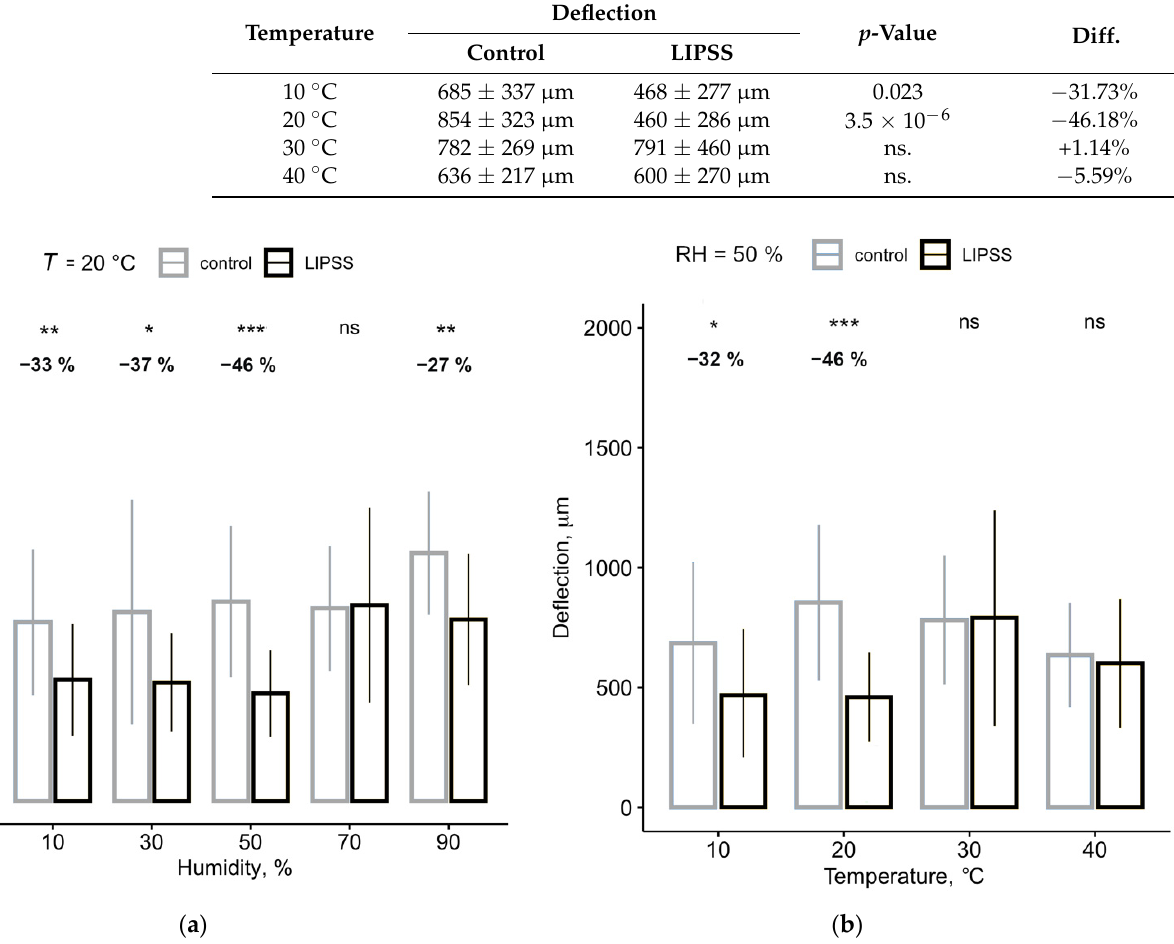
Figure 5. The anti-adhesive effect is most effective in laboratory conditions. Shown are the averaged maximum deflections of the threads before detaching from the surface. In the area above, the difference of the deflections between control and structured PET (in %) is indicated as well as the statistical relevance. ( a ) Comparison of LIPSS and control foil at different relative humidity levels but constant temperature ( T = 20 °C); ( b ) Comparison of LIPSS and control foil at different temperatures but constant humidity (RH = 50%). n = 25 for (a) and (b). Significant differences between LIPSS and control foils were determined by a Wilcoxon t -test. ∗ : p < 0.05, ∗∗: p < 0.01, ∗∗∗: p < 0.001, ns: not significant. Table 2. Indirect measurement of the adhesion (by deflection) of the threads at different temperature levels, presented as mean ± SD and the relative change between control and structured surface (Diff.). Significance was calculated using a Wilcoxon t -test, with p < 0.05.